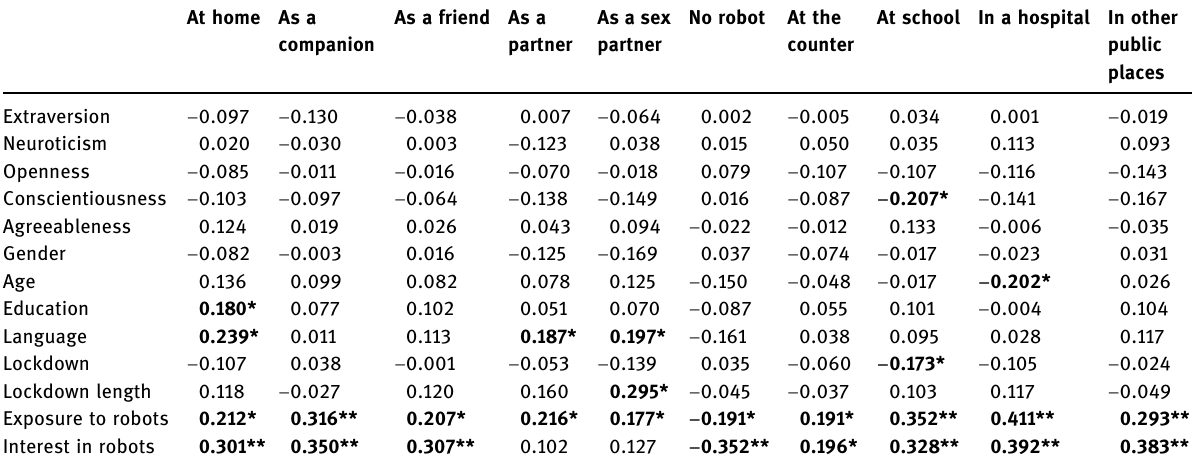
Table 4: Spearman ’ s rank correlation coe ffi cients ( r s ) between personal and demographic qualities and acceptance of robots at home/in public places in di ff erent